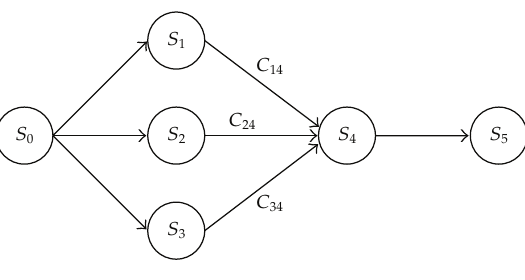
Figure 2: Directed acyclic graph (cid:3) DAG (cid:4)